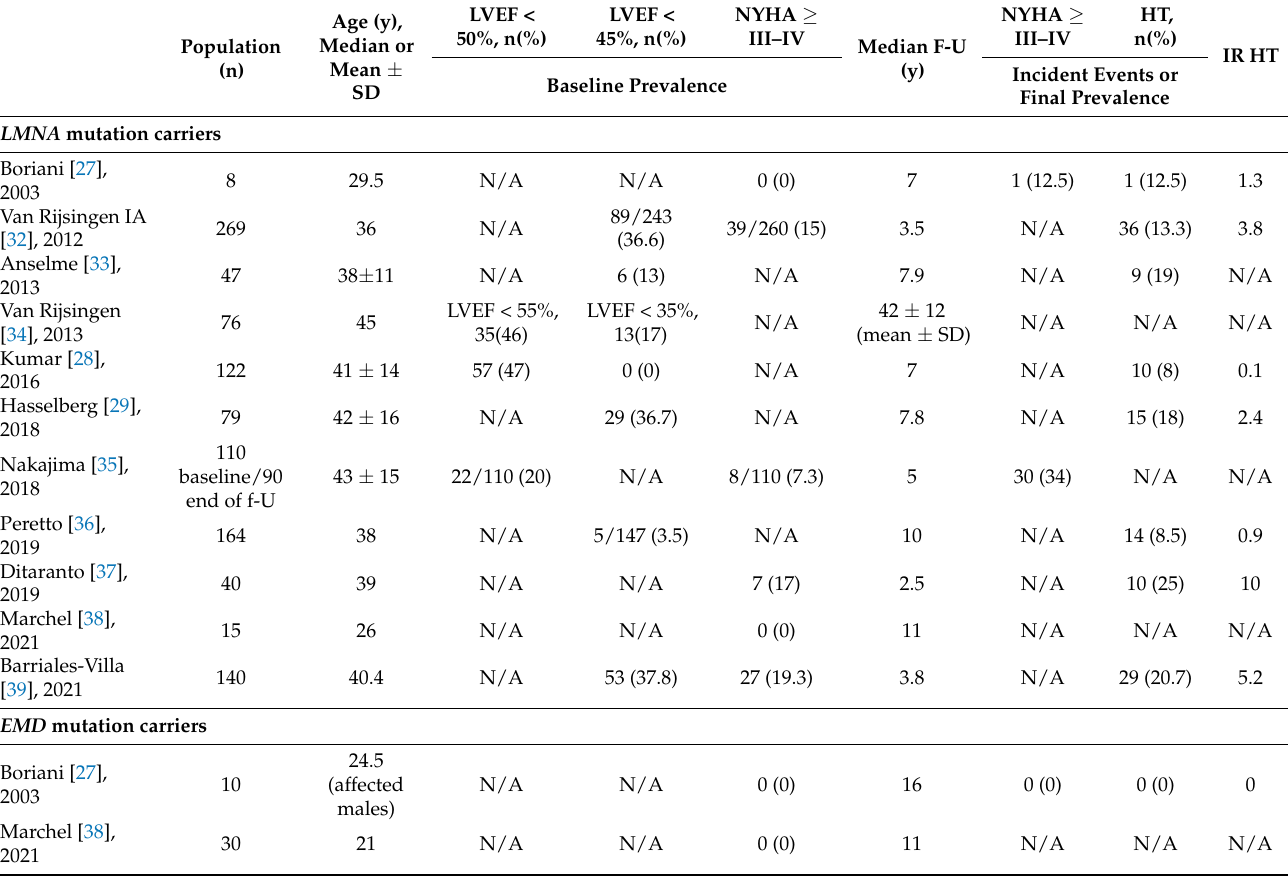
Table 7. Heart failure and heart